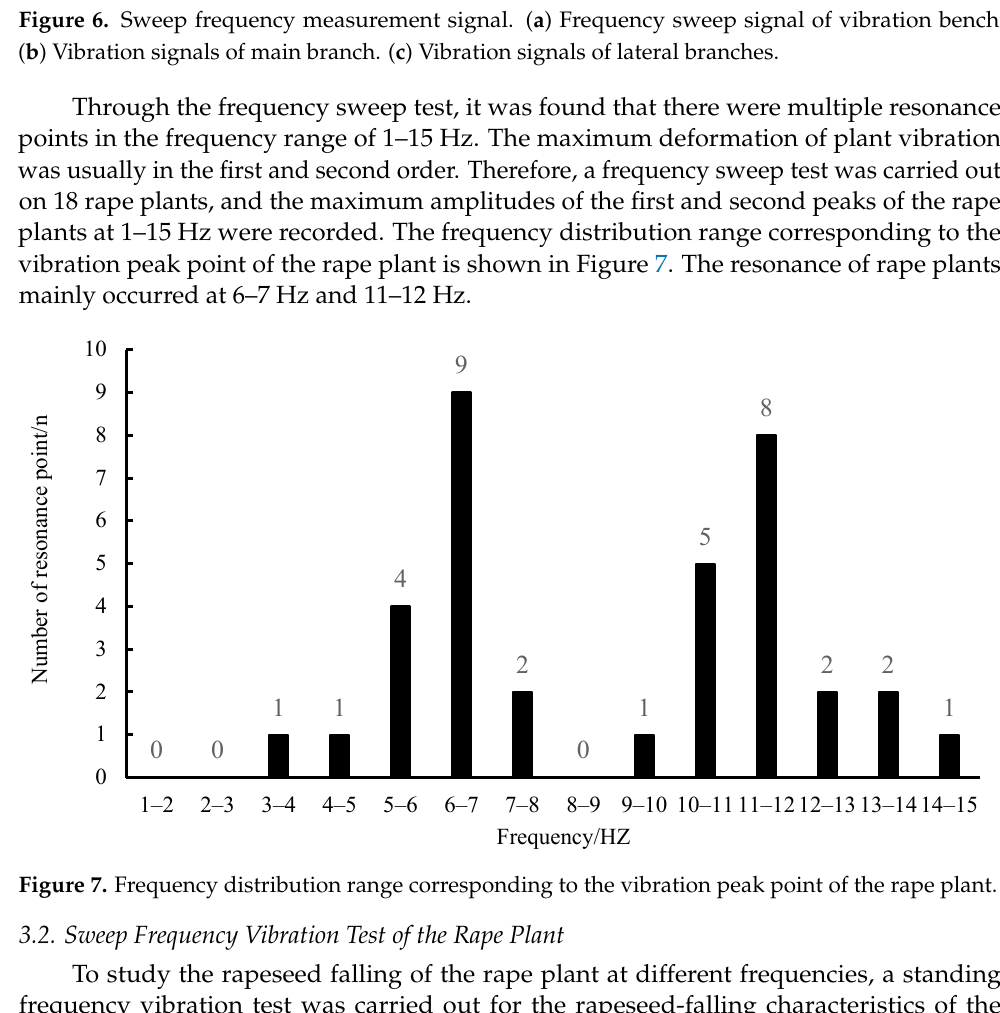
Figure 7. Frequency distribution range corresponding to the vibration peak point of the rape plant.